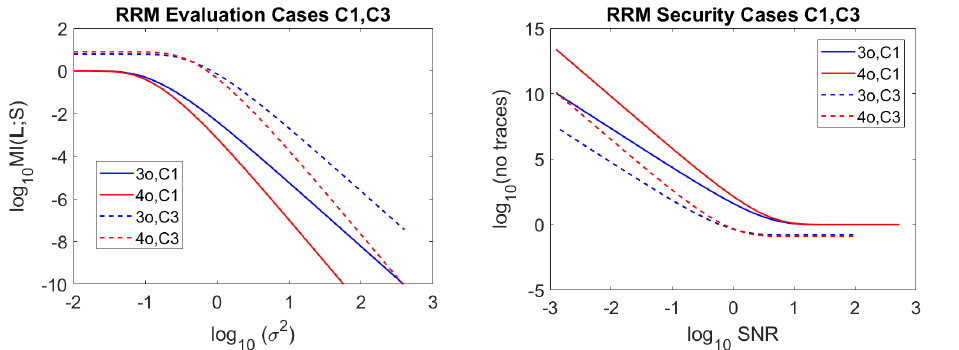
Figure 5: MI evaluation for 2nd and 3rd-order secure RRM schemes comparing naive-tuple (C1) with full-state attack (C3). Blue lines denote 3rd-order attack (vs. 2nd-order RRM) and red lines denote 4th-order attack (vs. 3rd-order